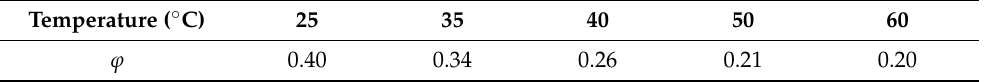
Table 2. Volume fraction of UPR ( φ ) at the ABS/ UPR interphase obtained from Equation (14).